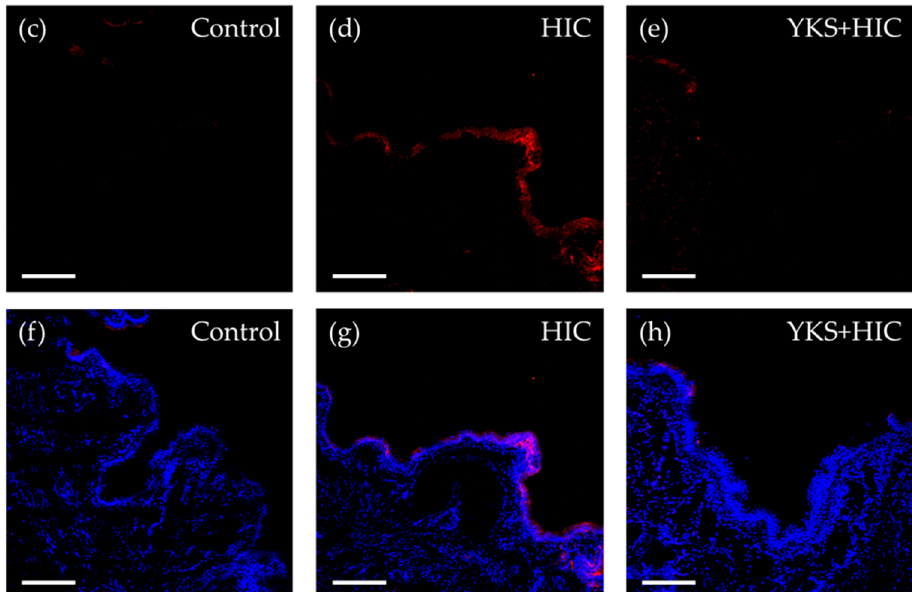
Figure 5. Oxidative Stress Parameters. ( a ) d-ROMs test; ( b ) 8-OHdG. Horizontal lines within boxes denote median values, and x marks denote the mean values. * Significant difference ( p < 0.05) (Kruskal–Wallis test with the post hoc test and Bonferroni correction). ( c – h ) Immunofluorescent staining of 8-OHdG in the bladder. The upper row ( c – e ) includes only 8-OHdG, and the lower row ( f – h ) includes 8-OHdG and nuclei. Red, 8-OHdG; blue, DAPI (nuclei). The white scale bar is 200 μ m. HIC, Hunner type interstitial cystitis; YKS, Yokukansan; d-ROMs, diacron reactive oxygen metabolites; 8-OHdG, 8-hydroxy-2 ′ -deoxyguanosine; DAPI, 4 ′ ,6-diamidino-2-phenylindole.